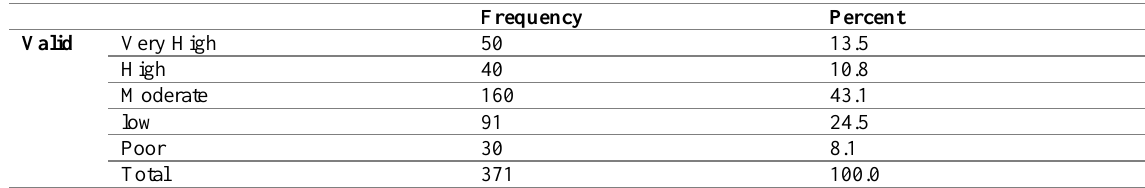
Table 5: Knowledge on Loyalty